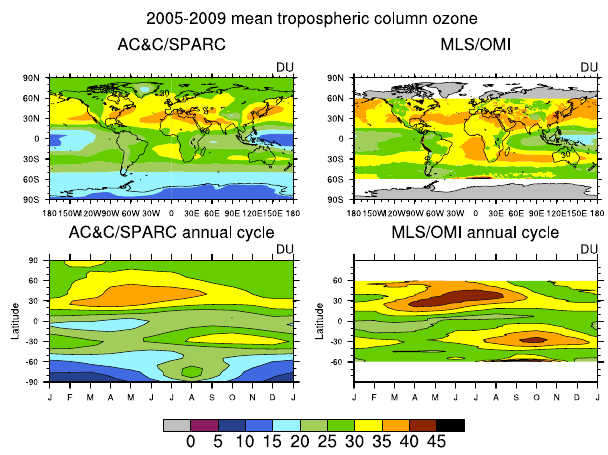
Fig. 8. Tropospheric column ozone averaged between 2005 and 2009 from the AC&C/SPARC ozone database compared to MLS/OMI observations (from Ziemke et al.,